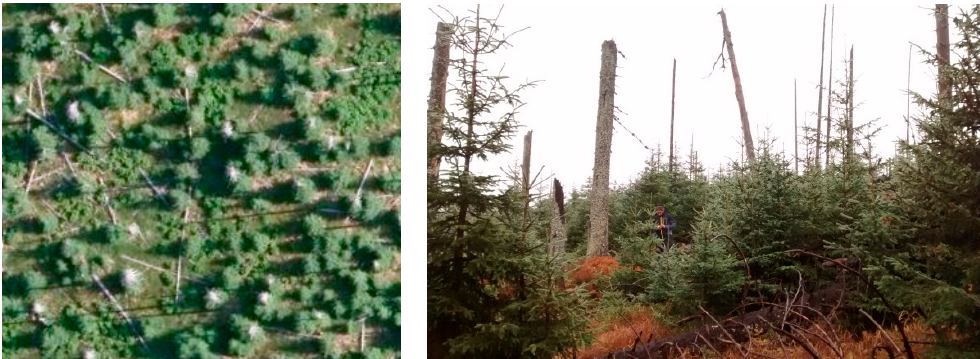
Figure A3. Aerial photo and photo of class A3.